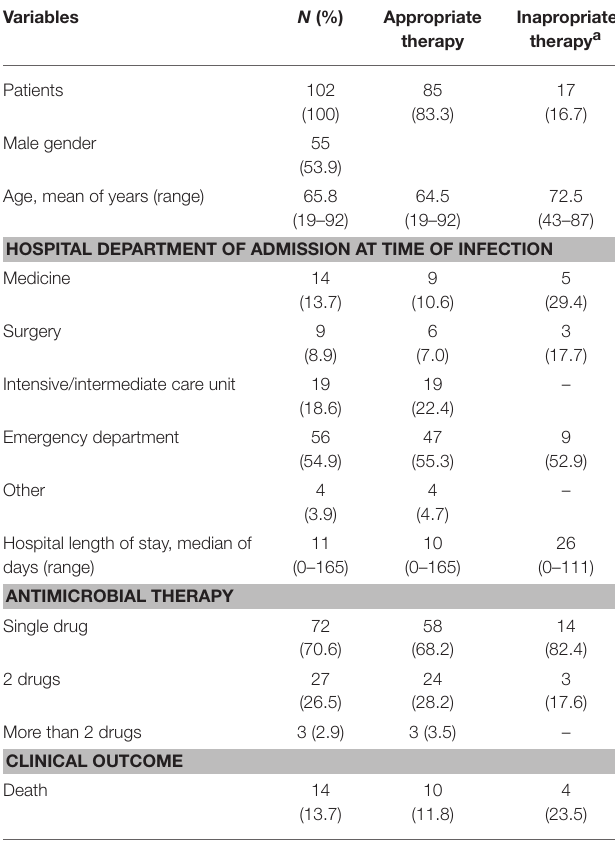
TABLE 1 | Data from 102 patients yielding positive blood cultures (March-July, 2015) included in the study and receiving empiric antibiotic therapy.